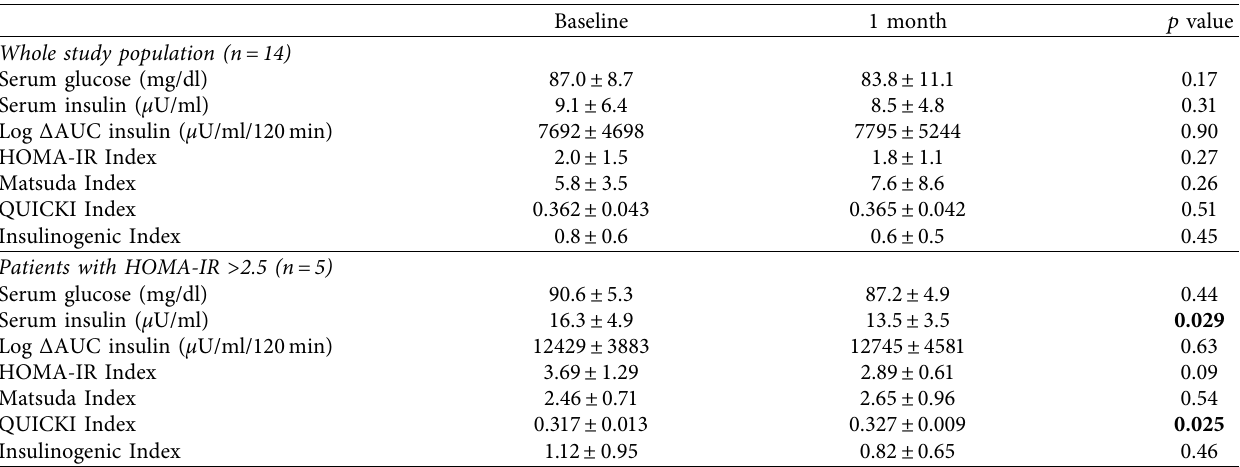
Table 2: Parameters of glucose metabolism of the patients at baseline and one month after denosumab injection. Data are expressed as mean ± SD.